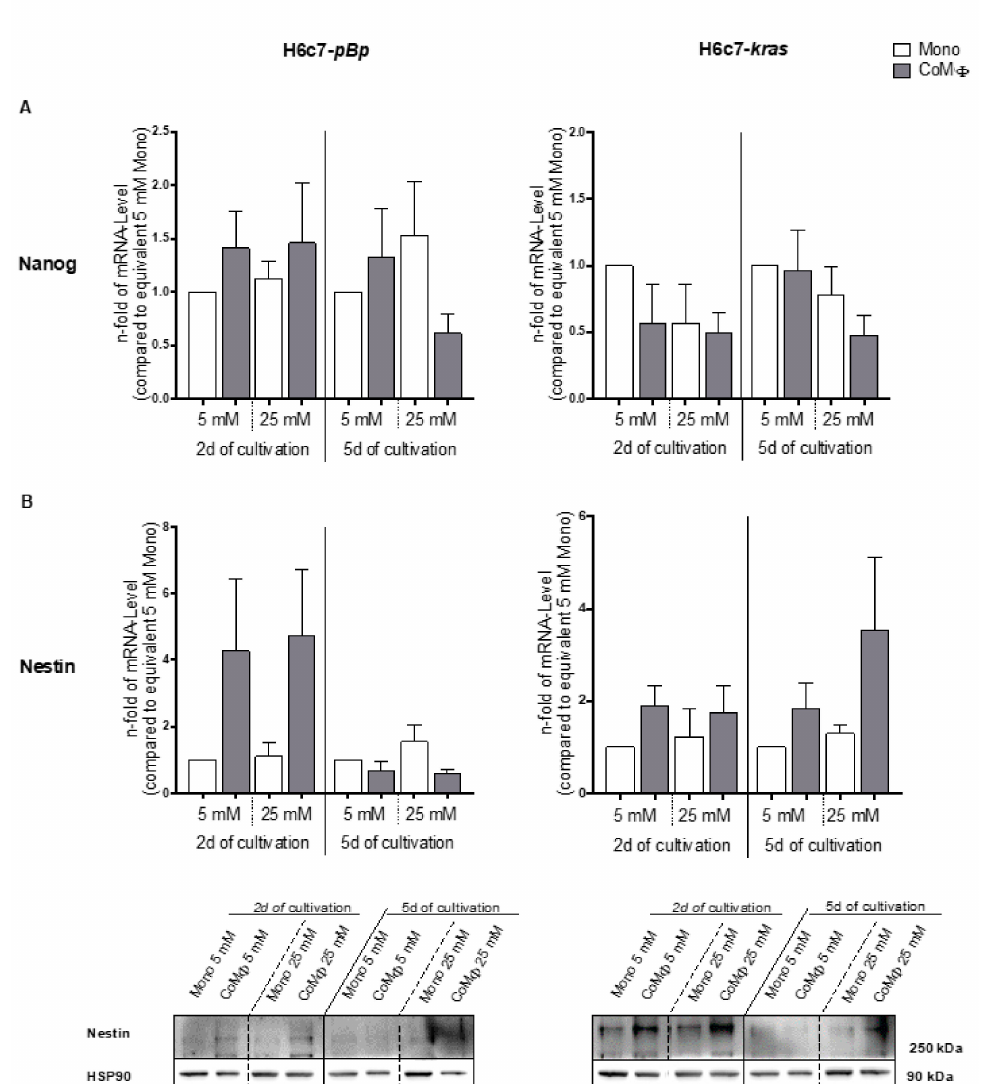
Figure 3. The presence of M1 macrophages and hyperglycemia changes the expression of CSC marker genes in PDEC. H6c7- pBp or H6c7- kras cells were cultivated in mono- or coculture with M1-polarized macrophages (M Φ ) under normo- or hyperglycemic conditions (5 or 25 mM of D -glucose) for 2 or 5 days. The epithelial cells were separated from direct coculture with macrophages via CD11b-MACS depletion of M1-M Φ or harvested from monoculture and used for qRT-PCR analysis. The relative mRNA levels of Nanog ( A ) and Nestin ( B ) for both cell lines are depicted. They are normalized to the housekeeping gene GAPDH and presented as n -fold expression compared with the monocultured 5 mM sample from the equivalent cultivation timespan. Normally distributed data are presented as mean and standard error of mean. n = 4 for 2-day culture, n = 7 for 5-day culture. In ( B ), protein levels of Nestin are also depicted; Hsp90 was used as loading control. A representative of three independent experiments is